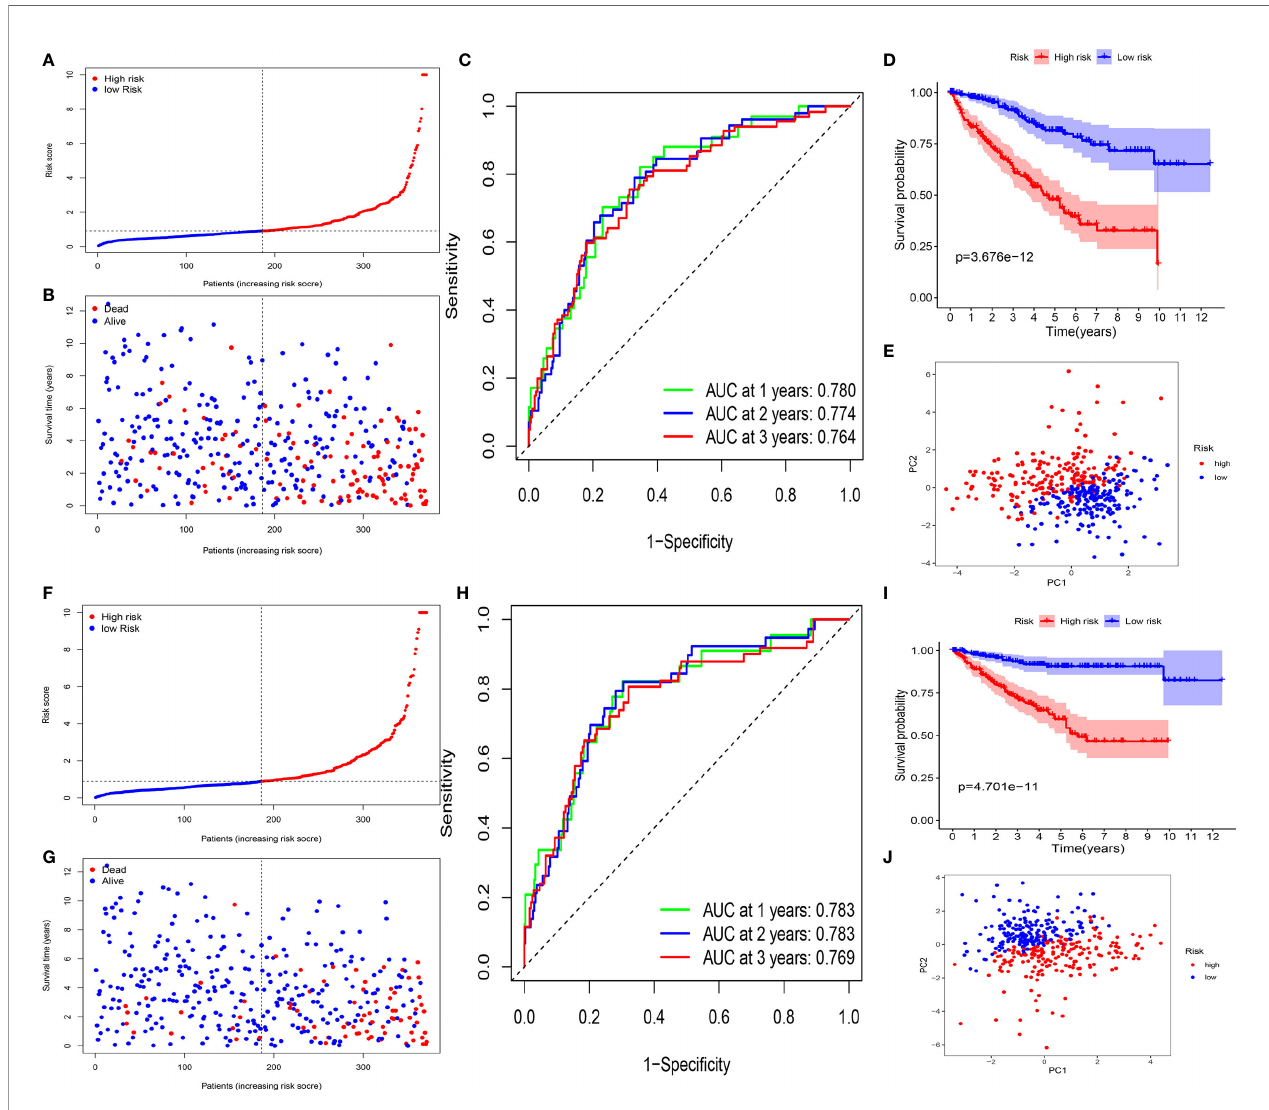
FIGURE 5 | Survival analyses of the signature in the training cohort. (A – E) Survival analyses for patients with OS. (A) Risk score distribution of patients. (B) Survival status scatter plot. (C) Time-dependent ROC curve. (D) Kaplan – Meier curve. (E) PCA plot based on the risk score. (F – J) . Survival analyses for patients with CSS. (F) Risk score distribution of patients. (G) Survival status scatter plot. (H) Time-dependent ROC curve. (I) Kaplan – Meier curve. (J) PCA plot based on the risk